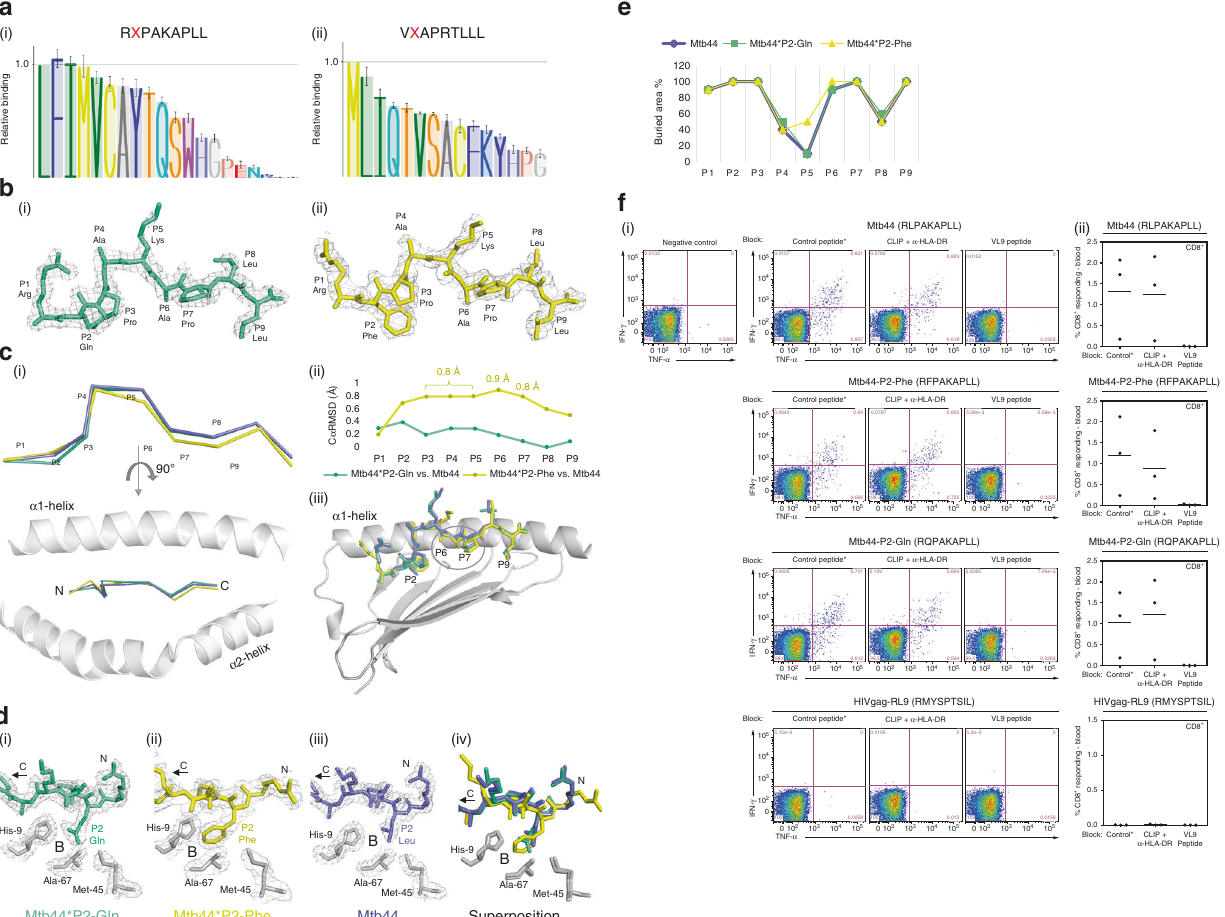
Fig. 3 Structural analyses of Mtb44 position 2 peptide variants: Mtb44*P2-Gln and Mtb44*P2-Phe. a Relative binding of Mtb44 ( i ) and VL9 ( ii ) position 2 peptide variants from single-chain peptide- β 2M-HC DNA constructs transfected in 293T cells and tested for HLA-E surface expression by fl ow cytometry using the MHC-E-speci fi c 3D12 antibody. Data scaled relative to the index position 2 residue of each peptide (Leu for Mtb44 and Met for VL9). Relative binding displayed on the y axis, with position 2 residue mutations on the x axis. The mean ± SEM of the MFI is reported ( n = 4). b : ( i ) The Mtb44 position 2 Glutamine variant Mtb44*P2-Gln (green-cyan) and ( ii ) the Mtb44 position 2 phenylalanine variant Mtb44*P2-Phe (yellow) visualised side-on with electron density overlaid in grey mesh and HC + β 2M omitted for clarity. c ( i ) C α backbone alignment of Mtb44*P2-Gln (green-cyan), Mtb44*P2-Phe (yellow) and Mtb44 (purple-slate) peptides visualised side-on and from above, respectively, with peptide binding groove α -1 + 2 helices depicted in grey cartoon. ( ii ) Distance in Å between superposed C α atoms of Mtb44*P2-Gln versus Mtb44 and Mtb44*P2-Phe versus Mtb44 with peptide residue position along the x axis and distance (Å) on the y axis. ( iii ) Superposition of Mtb44*P2-Gln (green-cyan), Mtb44*P2-Phe (yellow) and Mtb44 (purple-slate) peptides with peptide binding groove α 1 helix and β -sheet fl oor depicted in grey cartoon. d B pocket visualisation for ( i ) Mtb44*P2-Gln ( ii ) Mtb44*P2-Phe ( iii ) Mtb44 and ( iv ) Mtb44*P2-Gln/Mtb44*P2-Phe/Mtb44 superposition. HLA-E*01:03 HC-derived pocket-forming residues depicted as grey sticks with electron density overlay as grey mesh. e Buried residue area percentage for Mtb44*P2-Phe, Mtb44*P2-Gln and Mtb44 peptides with residue position along the x axis and buried area % on the y axis. f BCG-elicited Mamu-E-restricted Mtb44-speci fi c CD8 + T cells recognise Mtb44 position 2 variants. Peripheral blood mononuclear cells (PBMCs) from 3 BCG-vaccinated RM were stimulated with the Mtb44 (RLPAKAPLL) peptide, the position 2 peptide variants [Mtb44*P2-Phe (RFPAKAPLL), Mtb44*P2-Gln (RQPAKAPLL)] and the HIVgag-derived RL9HIV peptide. CD8 + T cell recognition determined and shown as described in Fig.